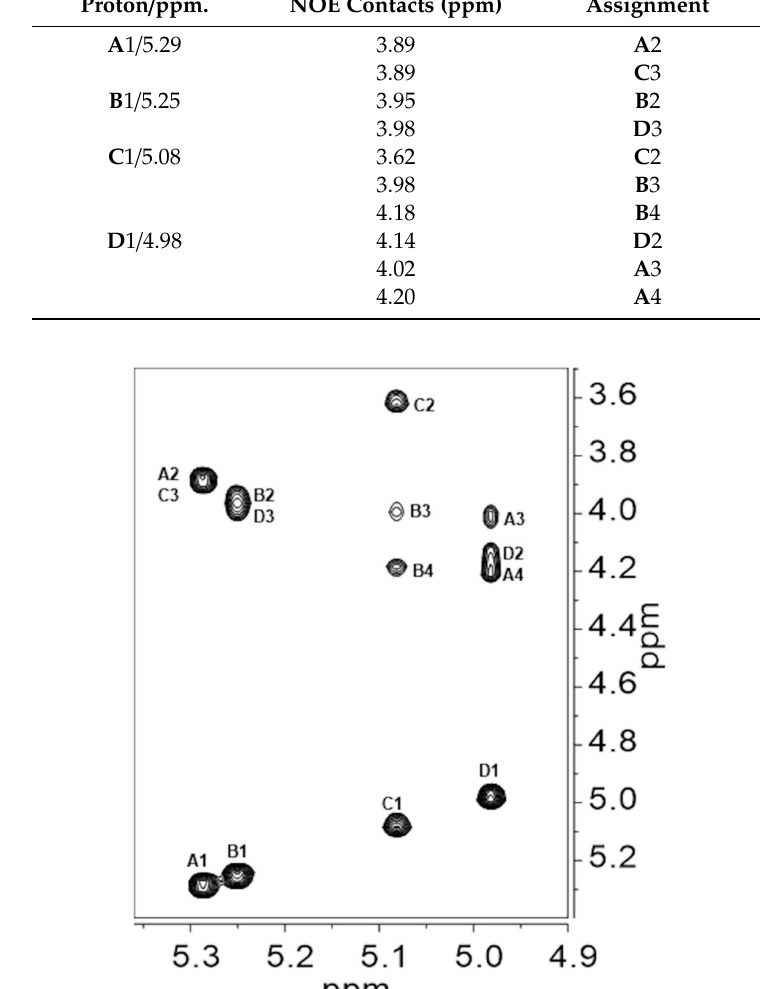
Table 2. Intra- and inter-residue Nuclear Overhauser E ff ect (NOE) contacts detected starting from the anomeric protons of the NOESY spectrum of Epol H111-INS in 0.3 M NaOD. Proton / ppm.